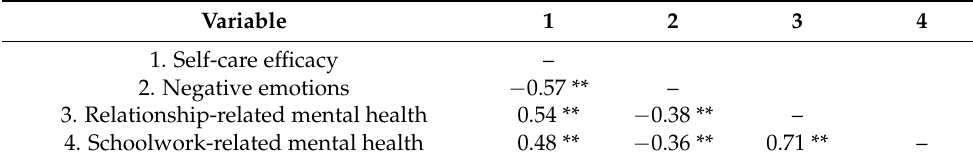
Table 2. Bivariate correlation of study